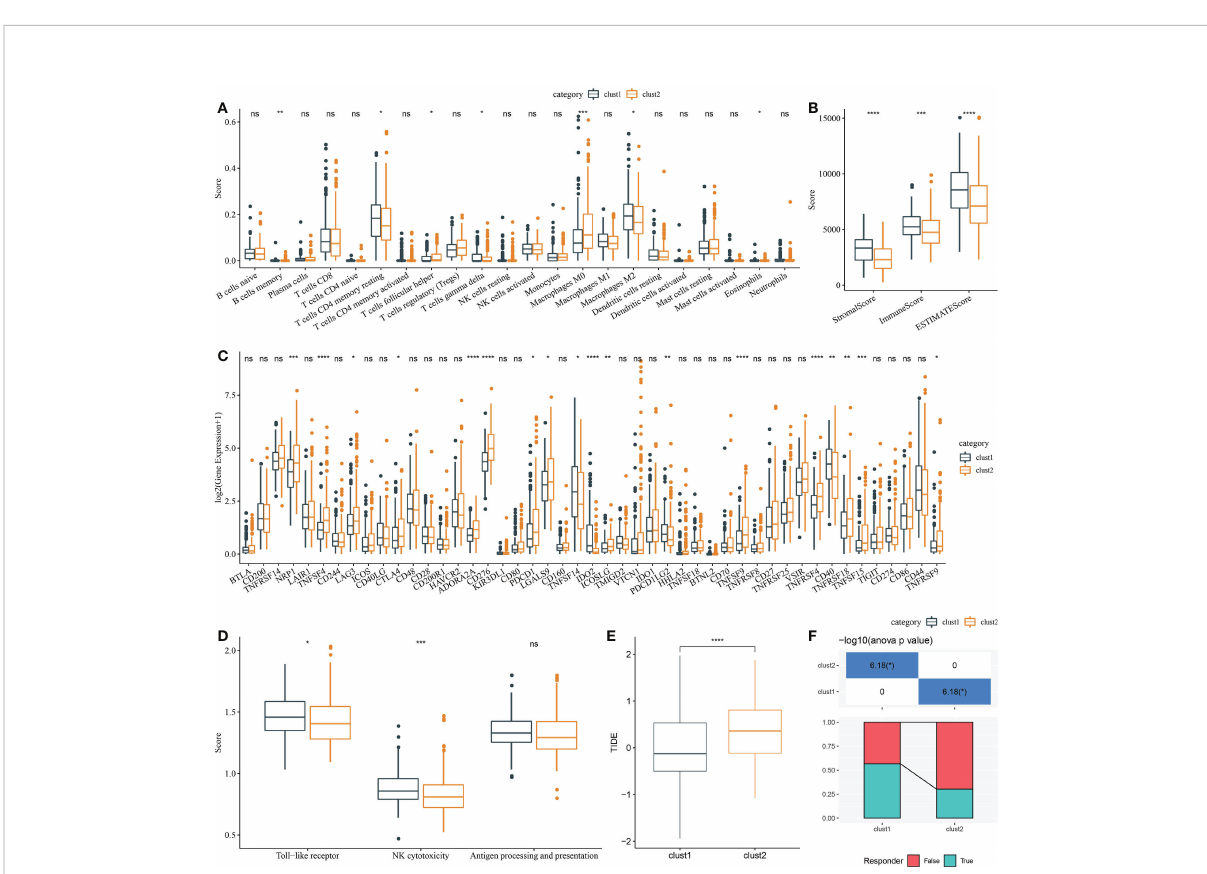
FIGURE 7 Analysis of immune in fi ltration. (A) Analysis of 22 immune cells using CIBERSORT. (B) Analysis of immune in fi ltration using ESTIMATE. (C) The expression levels of 42 immune check genes between Clust1 and Clust2. (D) The differences in Toll-like receptor signaling pathway score, natural killer cell-mediated cytotoxicity score, and antigen processing and presentation score between Clust1 and Clust2. (E) The differences in TIDE between Clust1 and Clust2. (F) Responses to immunotherapy between Clust1 and Clust2. *p<0.05, **p<0.01, ***p<0.001, ****p<0.0001, ns, no signi fi